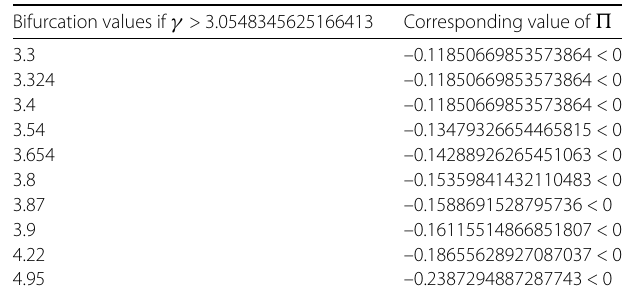
Table 1 Numerical values of (cid:15) for γ >